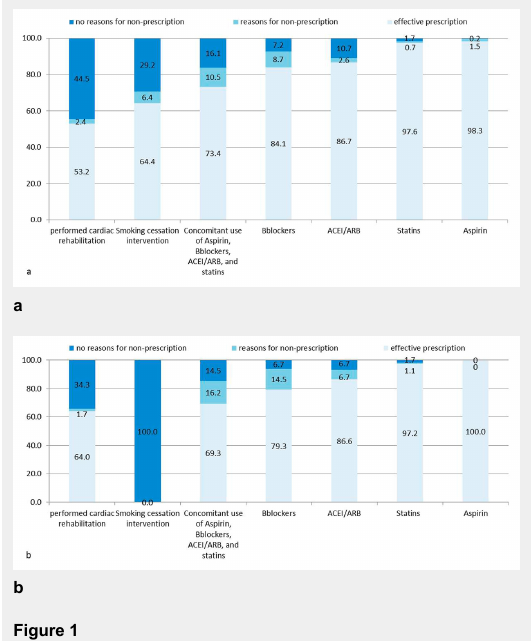
Secondary prevention therapies and interventions with documented contraindications according to presence of PCI facilities. (a) Hospital with PCI facilities. (b) Hospitals without PCI facilities. ACEI = angiotensin converting-enzyme inhibitors; ARB = angiotensin II receptor blockers; Bblockers = β-blockers; PCI = percutaneous coronary